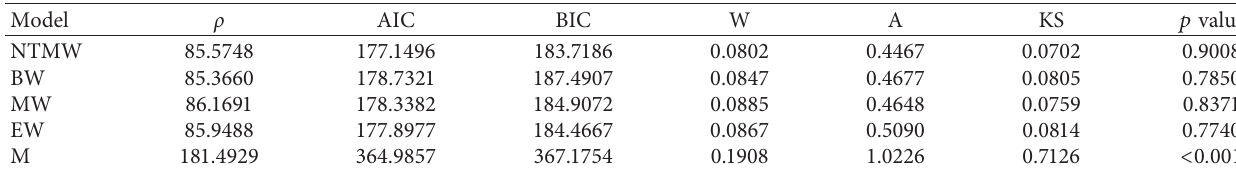
Table 11: Values of the considered criteria for dataset